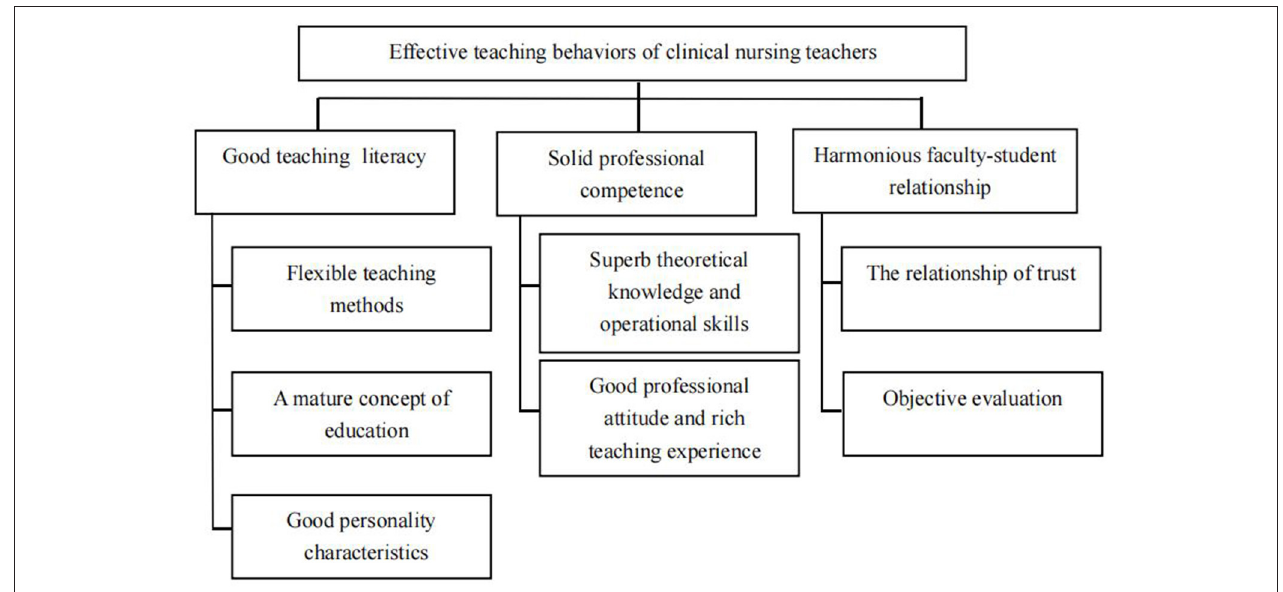
FIGURE 2 | The relation between meta-synthesis, themes, and categories in the review.